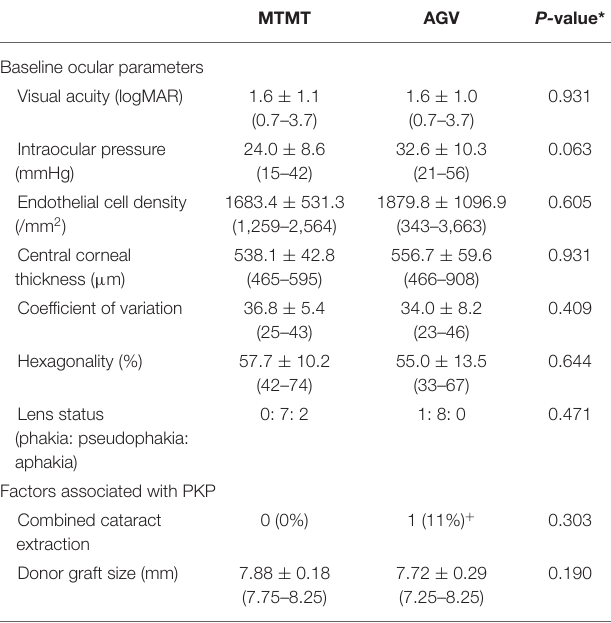
TABLE 3 | Clinical characteristics in the MTMT and AGV groups before AGV implantation.